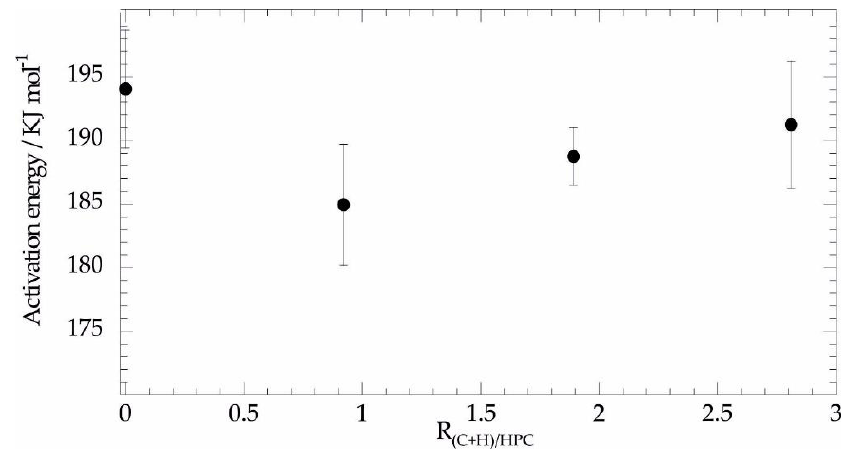
Figure 4. The average activation energy of hydroxypropyl cellulose (HPC) degradation as a function of the weight ratio between the middle layer (chitosan + halloysite nanotubes (HNTs)) and the outer layers (HPC).